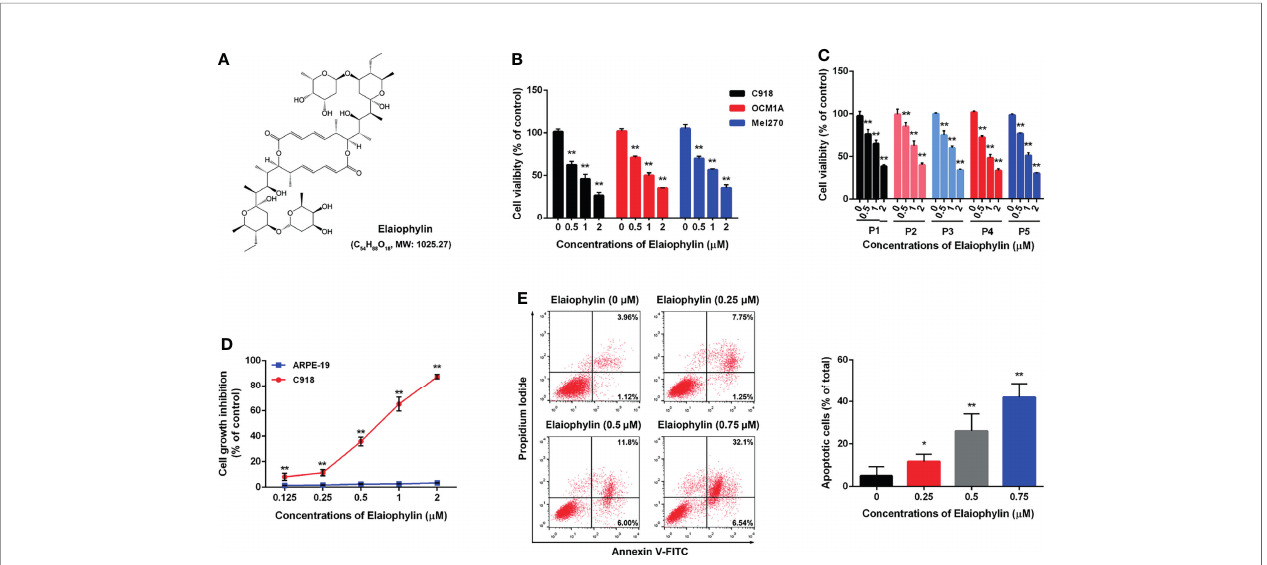
FIGURE 1 | Elaiophylin inhibits cell proliferation and induces autophagic cell death in C918 cells. (A) The chemical structure of Elaiophylin; (B) C918, OCM1A and Mel270 cells were treated with different concentrations of Elaiophylin (0, 0.5, 1 and 2 m M) for 24 h. Cell viability was determined by MTT assay. (C) Five primary UM cells were treated with different concentrations of Elaiophylin (0, 0.5, 1 and 2 m M) for 24 h. Cell viability was determined by MTT assay. (D) C918 and ARPE-19 cells were treated with different concentrations of Elaiophylin (ranged from 0 to 2 m M) for 24 h. Cell viability was determined by MTT assay. (E) C918 cells were treated with indicated concentrations of Elaiophylin for 24h, and then apoptotic cells stained with Annexin V-FITC/PI were detected with fl ow cytometry. Apoptotic rates are shown in bars. Data was expressed as mean ± SD of three experiments and each experiment included triplicate repeats. * p <0.05, ** p <0.01 vs.